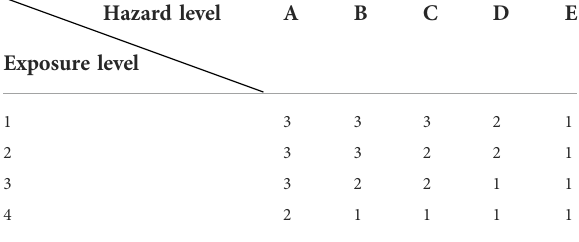
Table 1. The sampling process was performed in a machine factory in April 2019 on a sunny day, during which the outdoor temperature ranged from 17 ° C to 22 ° C. The outdoor air velocity was low (0.41 ± 0.04 m/s). According